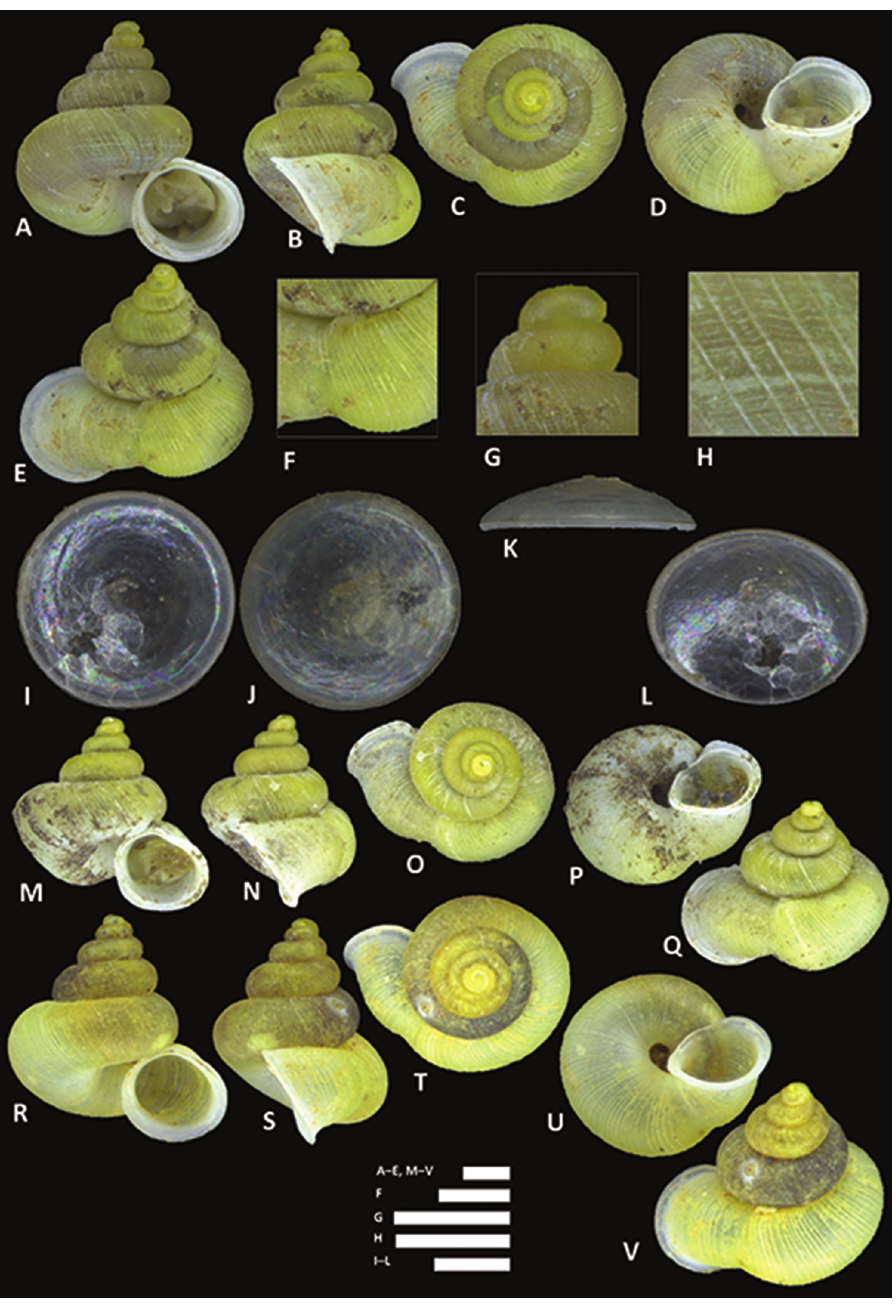
Figure 15. Alycaeus costacrassa sp. n. A–E Shell of holotype, BOR/MOL 6811 F–H Close up of shell of holotype, BOR/MOL 6811 I–L Operculum of holotype, BOR/MOL 6811 M–Q Shell of BOR/MOL 6818 R–V Shell of BOR/MOL 12992. Scale bars: A–G 1 mm; H, I–L 0.5 mm. All photographs by Junn Kitt